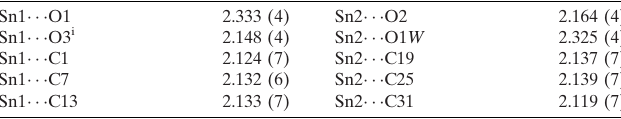
Selected interatomic distances (A˚ ).